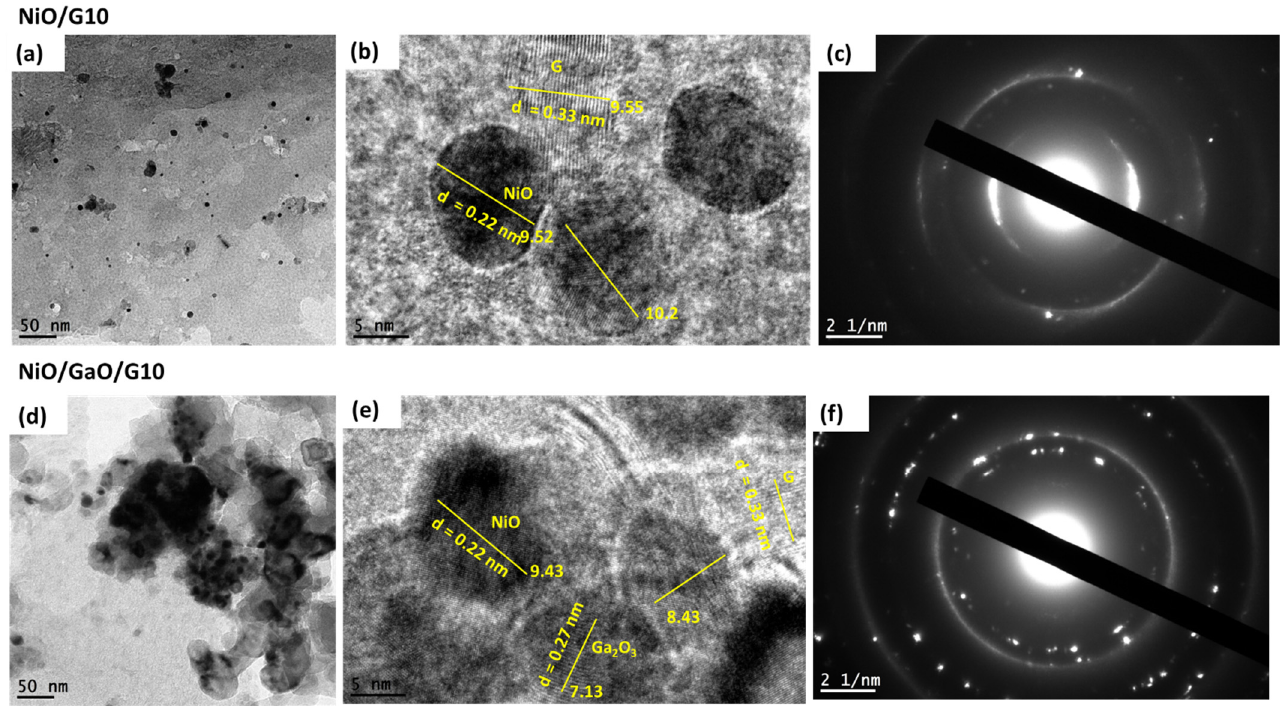
Figure 2. ( a , d ) TEM images; ( b , e ) fringe patterns; and ( c , f ) SAED patterns for NiO/G10 and NiO/Ga 2 O 2 /G10, respectively.